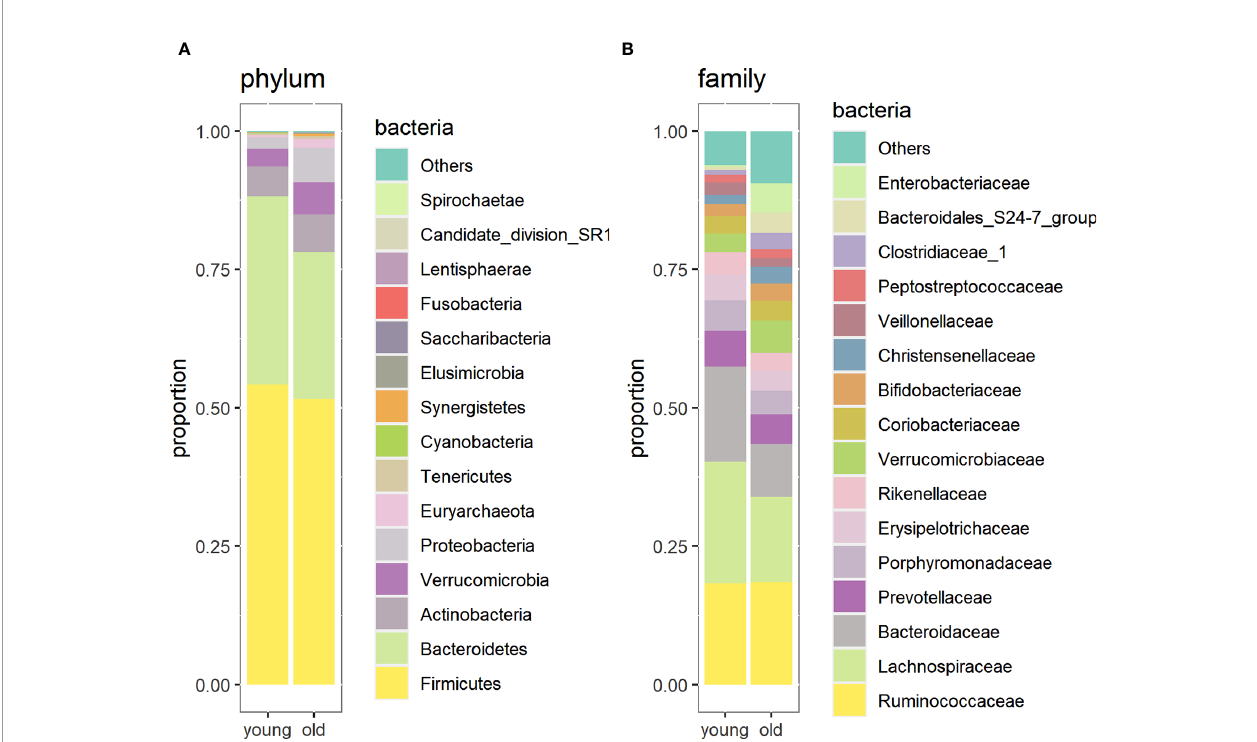
FIGURE 3 | Relative abundance of gut microorganisms in the oldest-old and young groups at the phylum level (A) and family level (B)